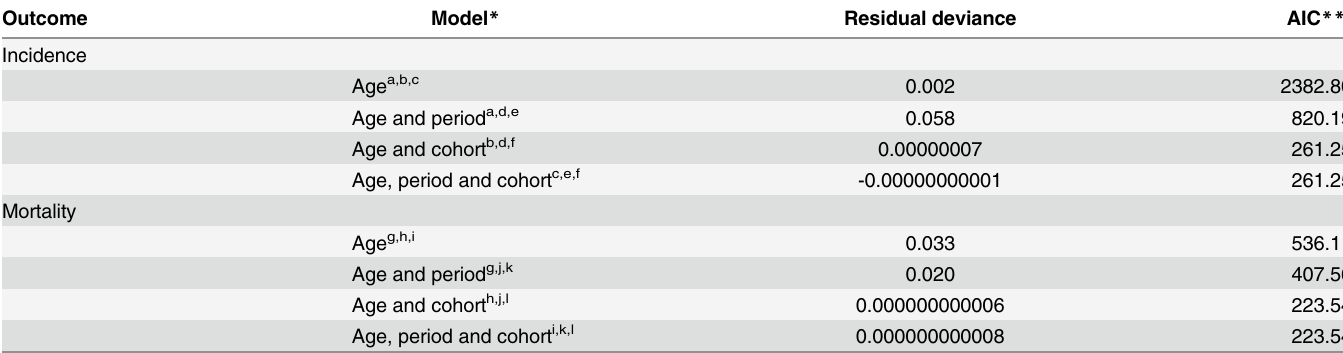
Table 2. Age-Period-Cohort Modeling for Incidence and Mortality of Breast Cancer in Women using glm of R package. Outcome